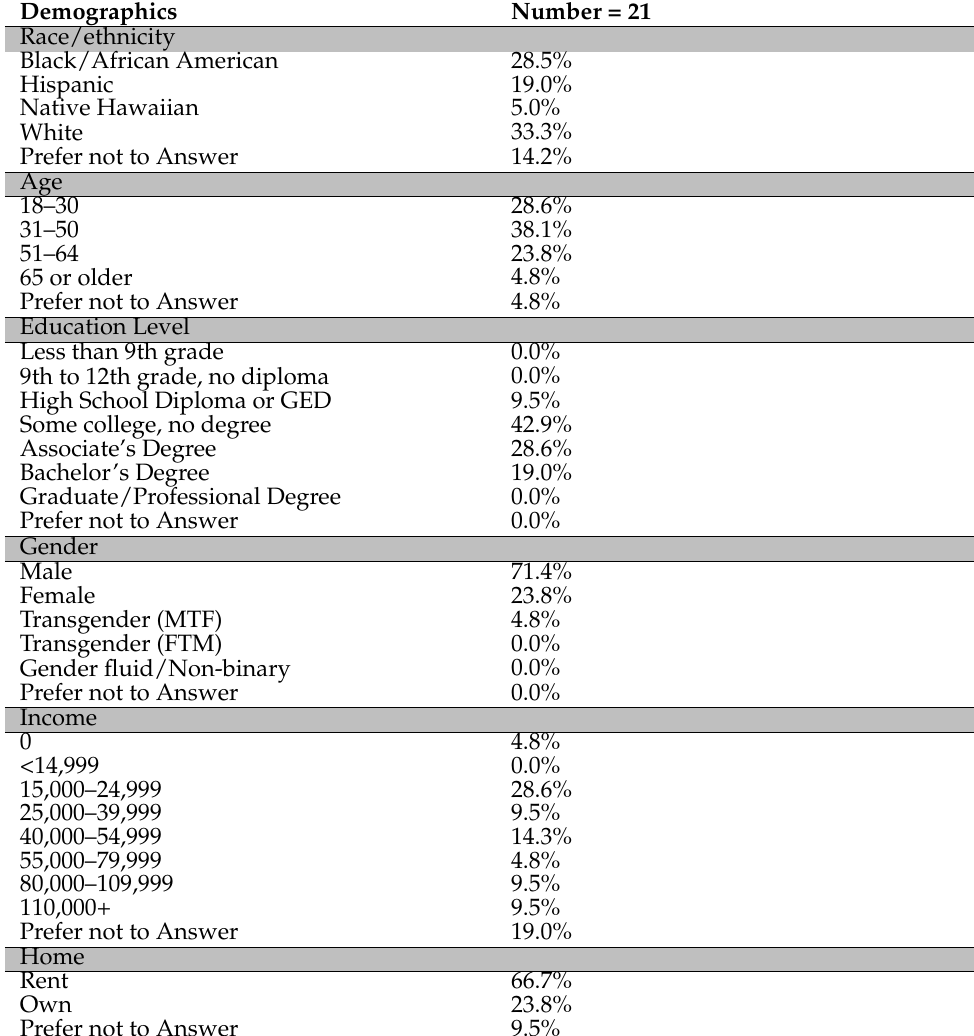
Table 1. Demographic characteristics of the